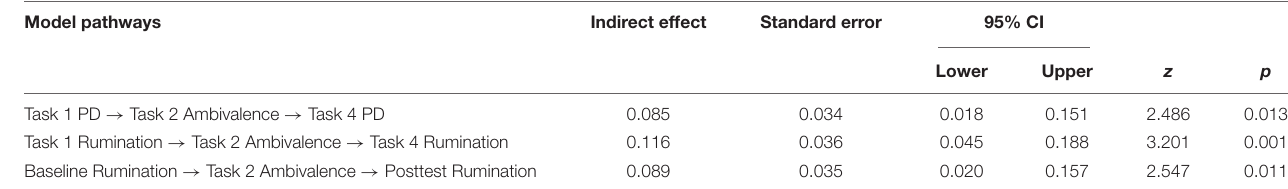
TABLE 8 | Standardized indirect effects with 95% confidence intervals. Model